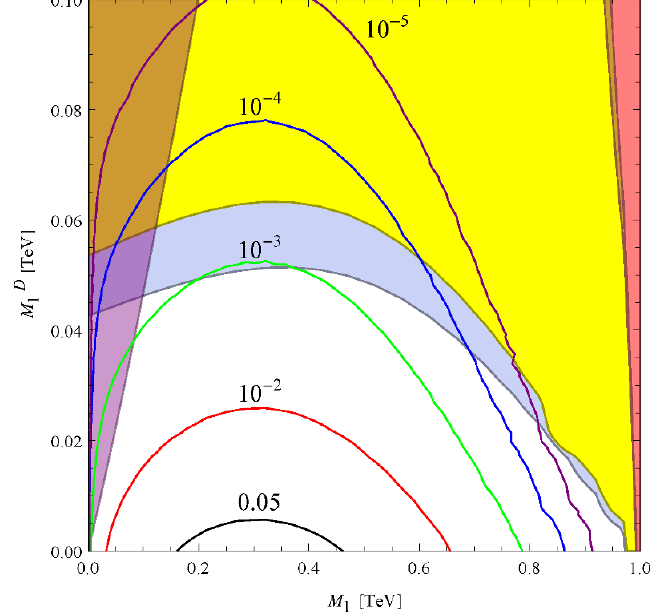
Figure 23. Contour plots of constant (cid:10) (cid:1) B for decoupled Higgsinos and gluinos. The blue region corresponds to (cid:31) B decaying before electroweak phase transition. The yellow region corresponds 2 to (cid:31) B decaying before freeze-out. The purple and pink regions correspond to (cid:31) B 2 temperature superior to m B and m B 1 2